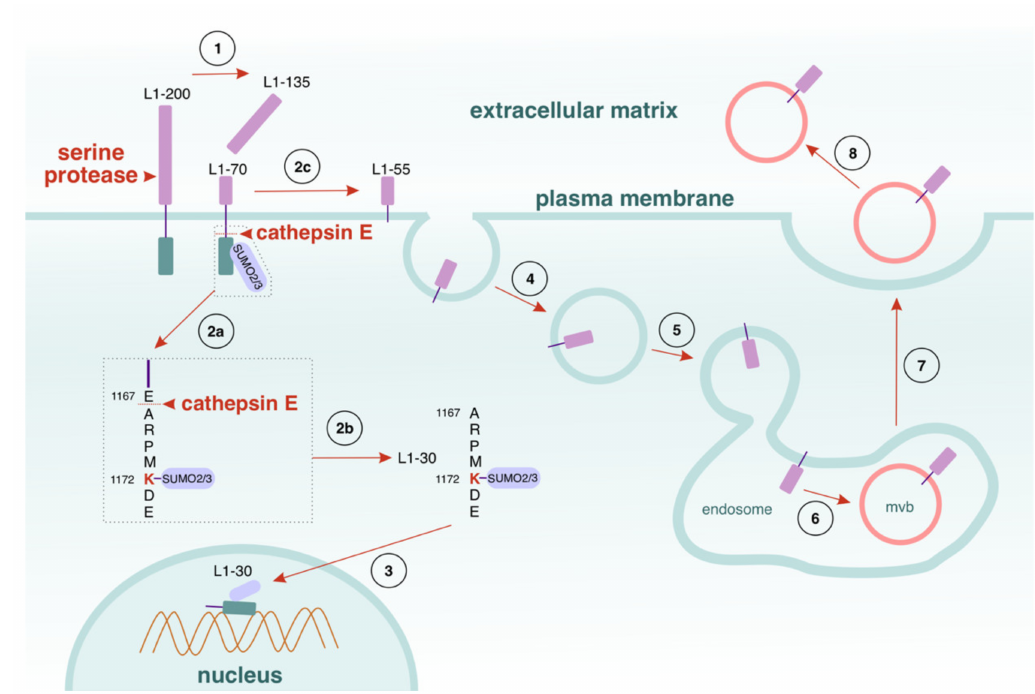
Figure 3. The formation and intracellular pathways of L1-30. (1) After generation from full-length L1 (L1-200), L1-70 is sumoylated by sumo-2 and/or sumo-3, and becomes a substrate for the enzyme cathepsin E, (2a) which cleaves L1 at E 1167 . As a result, two new fragments are generated: a soluble L1-30 fragment (2b) and L1-55 (2c). (3) Once discharged into the cytoplasm, L1-30 enters the nucleus. (4, 5) L1-55 remains bound to the plasmalemma, and from there it is directed to the late endosomes (6). In the endosomes, L1-55 is embedded into multivesicular bodies (mvb) and subjected to exocytosis into the ECM ( 7 ) by exosomes